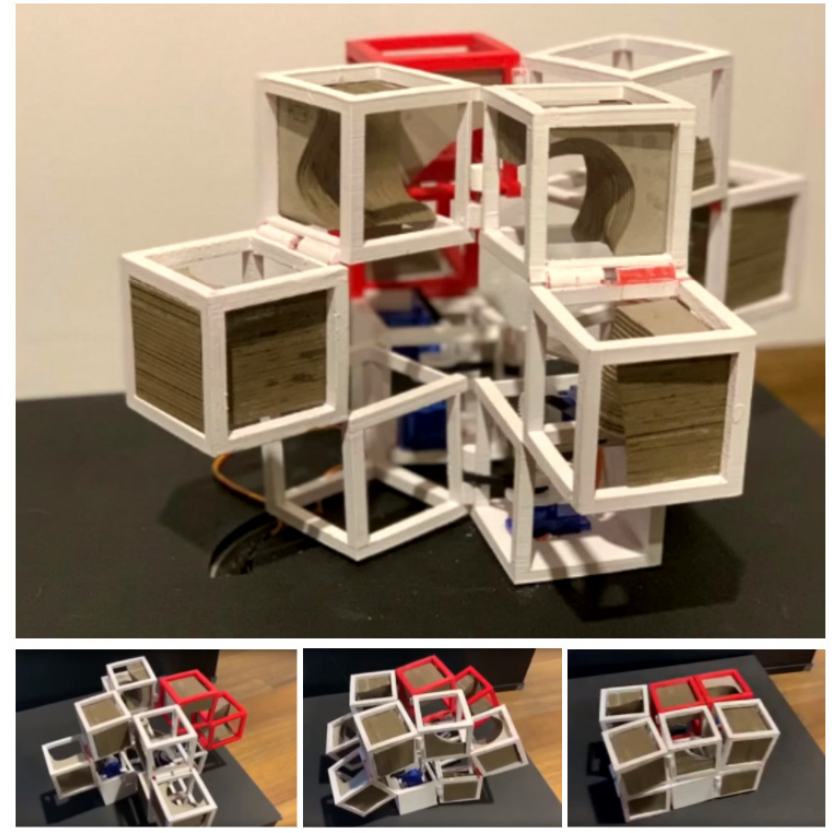
Figure 12. A three-dimensional, kinetic model representing a structure consisting of 12 cubes, with a position that may change depending on the expected function.